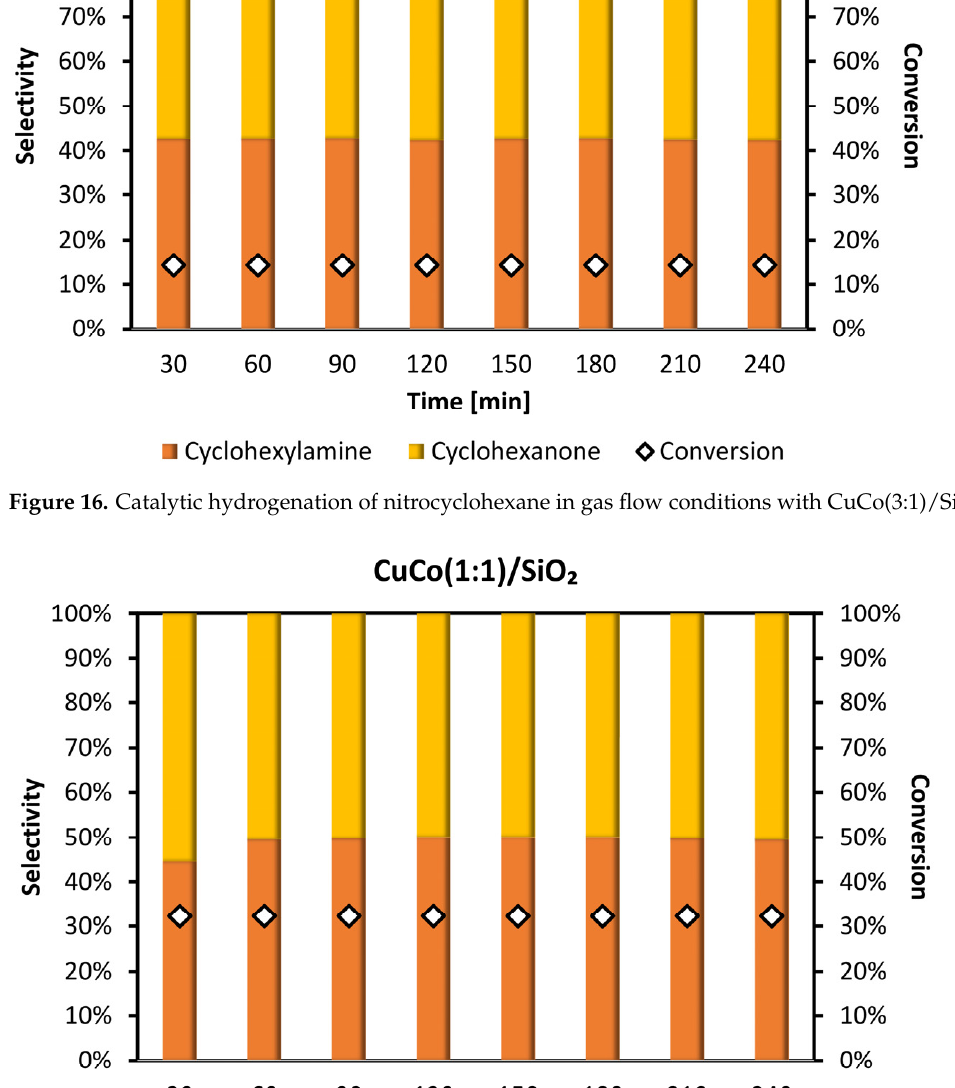
Figure 18. Catalytic hydrogenation of nitrocyclohexane in gas flow conditions with CuCo(1:3)/SiO 2 . 2.6. Catalytic Hydrogenation of Nitrocyclohexane–Mechanism Catalytic hydrogenation of nitrocyclohexane is still an under-researched area. Most of the research groups concerning this process proposed their own mechanisms. All of them were summarized by Kowalewski et al. [10]. In general, the nitrocyclohexane hydro- genation process could be presented as in Scheme 1. However, based on the mechanistic studies of Yao et al. [18], verifying the course of nitrocyclohexane hydrogenation is essen- tial. Hence, the catalytic performance of the selected catalysts was examined at specific reaction conditions (40 bar, 100 °C). The results summarized in Table 2 confirmed that nitrocyclohexane hydrogenation on CuCo catalysts occurs by the pathway presented in Scheme 1.